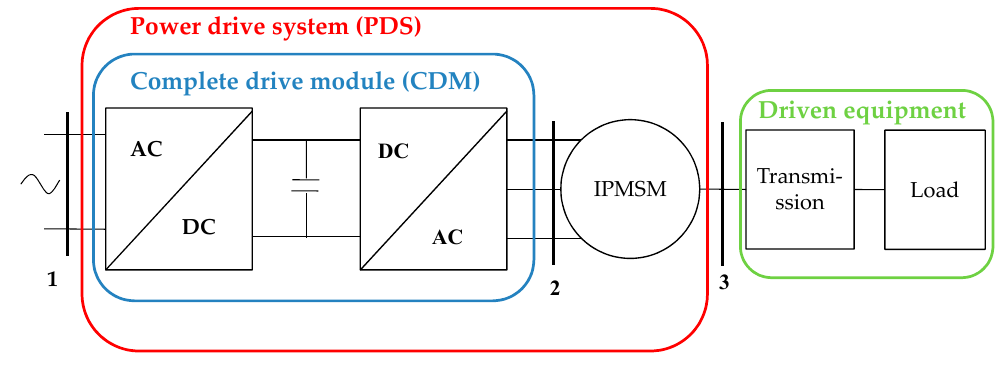
Figure 1. Schematic representation of a PDS.